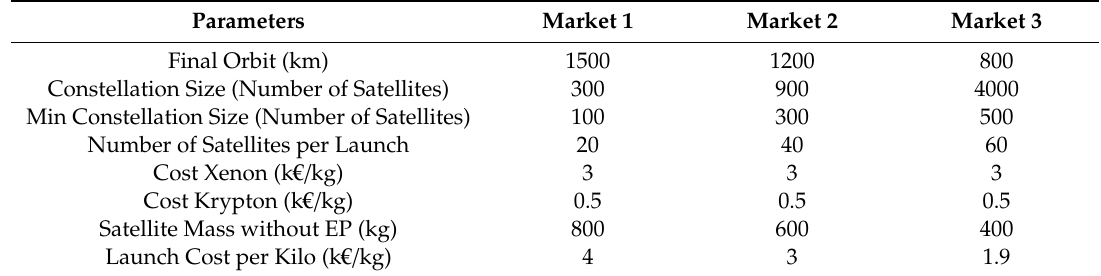
Table 1. Input data for the market scenarios considered in the present